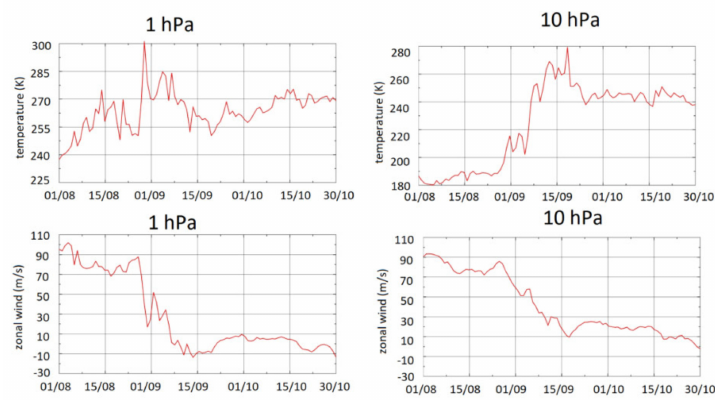
Figure 3. The same as Figure 2 but for the period 1 August 2019–30 October